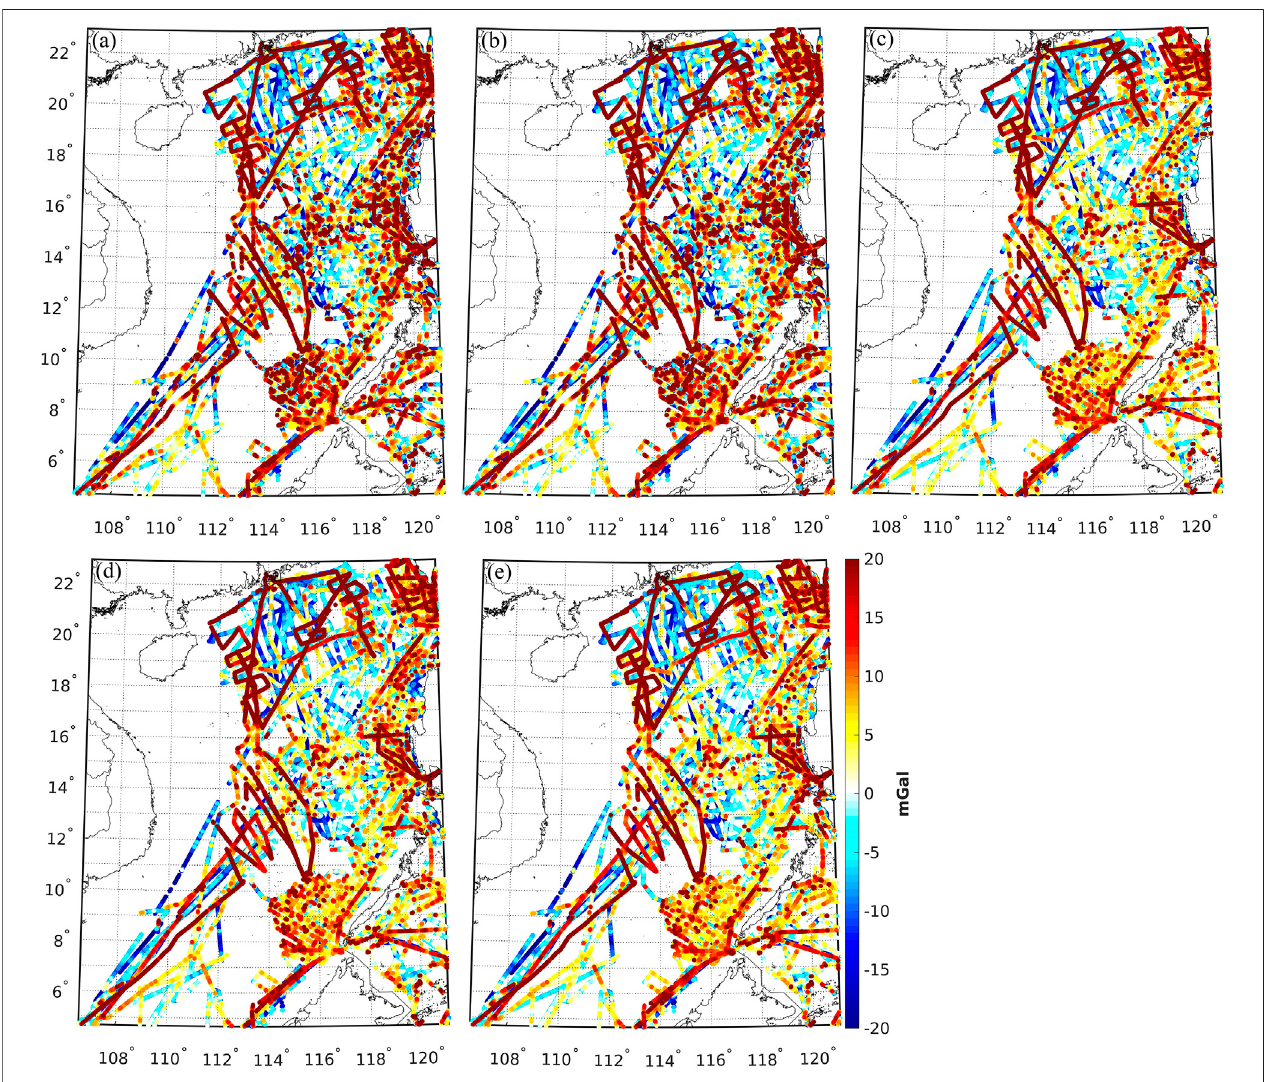
FIGURE 5 | Differences between shipborne gravity anomalies retrieved from NGDC and quantities synthesized from (A) GOCO05c (d/o 720), (B) XGM2019 (d/o 760), (C) EGM2008 (d/o 2190), (D) EIGEN-6C4 (d/o 2190), and (E) XGM2019e_2159 (d/o 2190) over South China Sea.